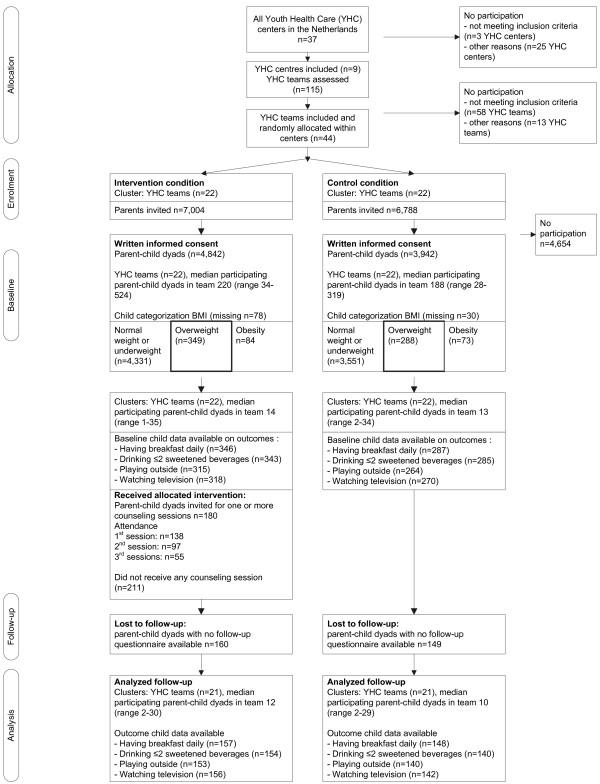
Flow diagram of the selection and follow-up of study participants.